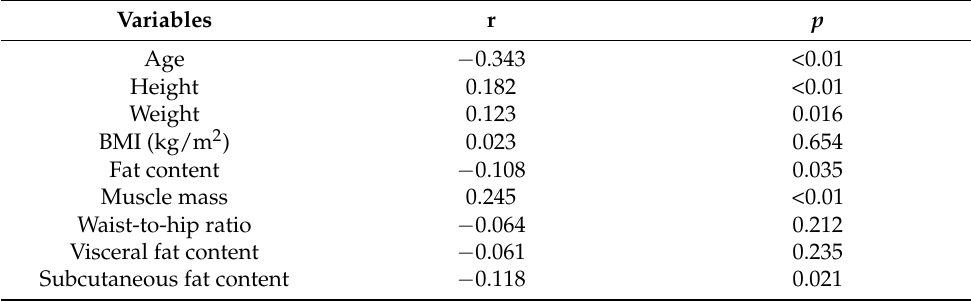
Table 2. Correlation analysis of bone strength index with each index.